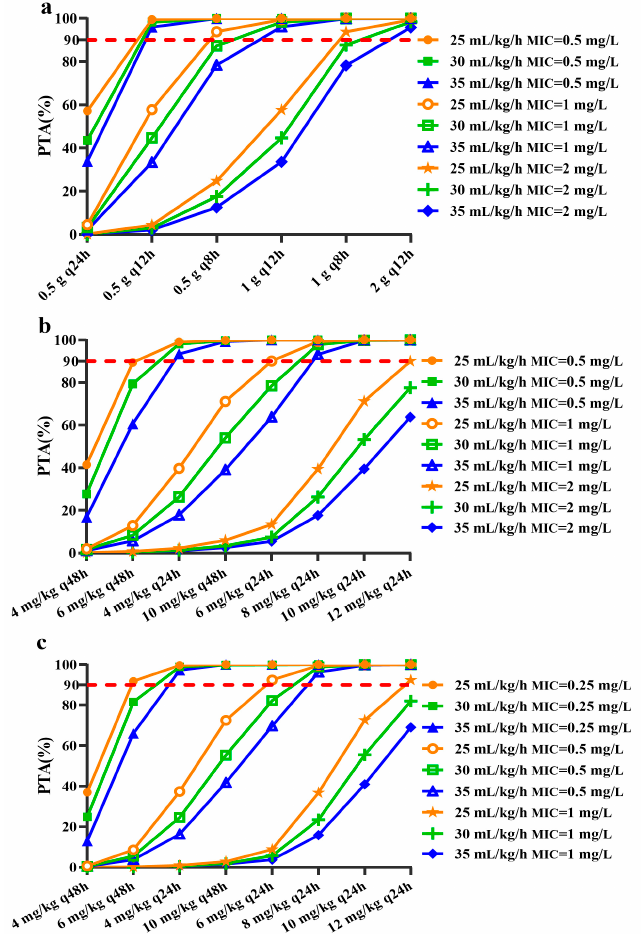
Figure 4. The probability of target attainment (PTA) values in different maintenance doses for patients undergoing different continuous renal replacement therapy (CRRT) doses. CRRT doses were fixed as 25, 30 and 35 mL/kg/h, respectively. The red dashed horizontal line indicates 90% PTA. ( a )—Vancomycin; ( b )—Teicoplanin; ( c )—Daptomycin. Table 2. The dosage recommendations of three antimicrobial agents for treating MRSA infections with various MICs for critically ill patients undergoing CRRT.